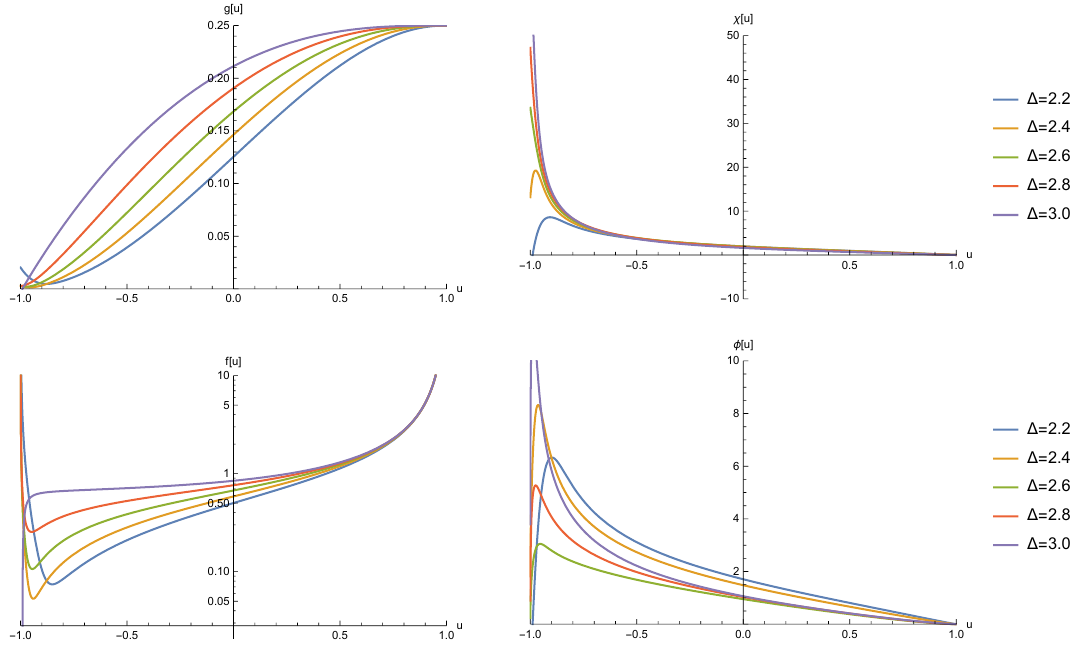
Figure 11 . Massive non-singular solutions for d = 3 with α = 4.2756, 4.0026, 3.6125, 3.1150, 2.5210 for ∆ = 2.2, 2.4, 2.6, 2.8, 3.0,